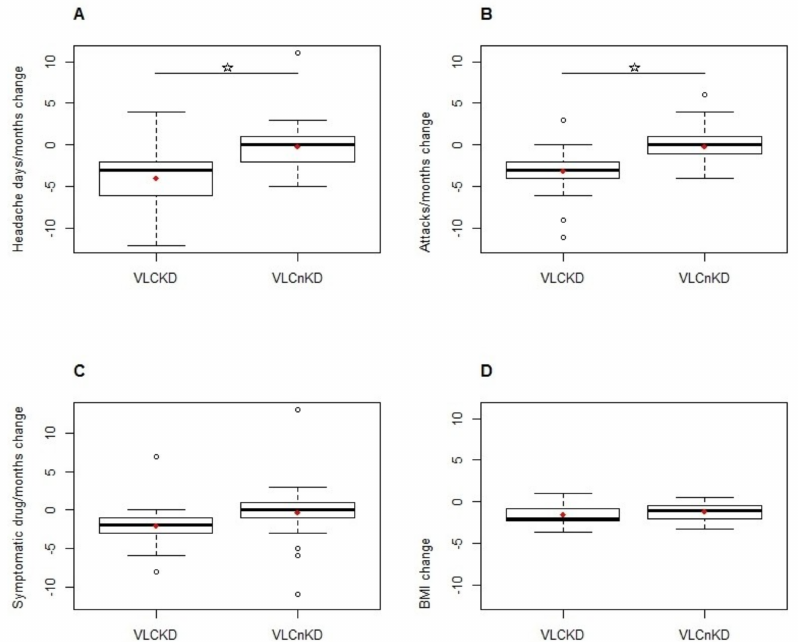
Figure2. Box-plotsdepicttreatmente ff ects(VLCKDvs. VLCnKD)onchangesinHeadachedays / months ( A ), Attacks / months ( B ), Symptomatic drugs / months ( C ) and BMI ( D ). In the figures: solid lines indicate median values; boxes show 25% to 75% range; whiskers include non-outlier range; circles indicate outlier and extreme values; red diamonds represent mean values. VLCKD: ketogenic very low-calorie diet; VLCnKD: non-ketogenic very low-calorie diet. In figures A and B the horizontal bar and star indicate statistical significance. Star indicates statistical significance. Circles indicate the presence of outliers’